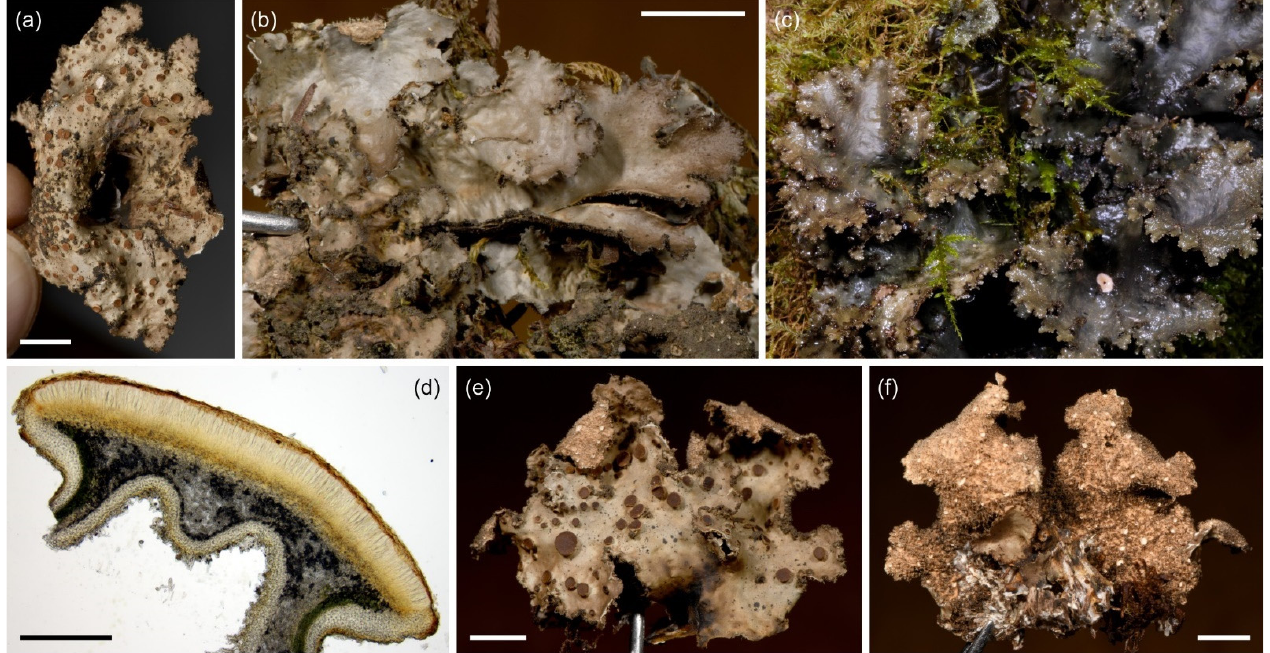
Figure 7. Sticta afromontana . ( a ) Type specimen UK170826e collected from the upper montane forest on Mt. Kilimanjaro. The specimen has laminal isidia that are not present in specimens without apothecia. ( b ) Specimen JR16366 illustrating typical habit with marginal isidia. ( c ) Specimen JR10112 photographed in situ on Vuria Mountain. ( d ) Cross section of an apothecium from the type specimen. ( e , f ) Thallus part of the same collection as the type imaged from the upper and lower side. Scales 0.5 cm in ( a , b , e , f ), 300 µm in ( d ).